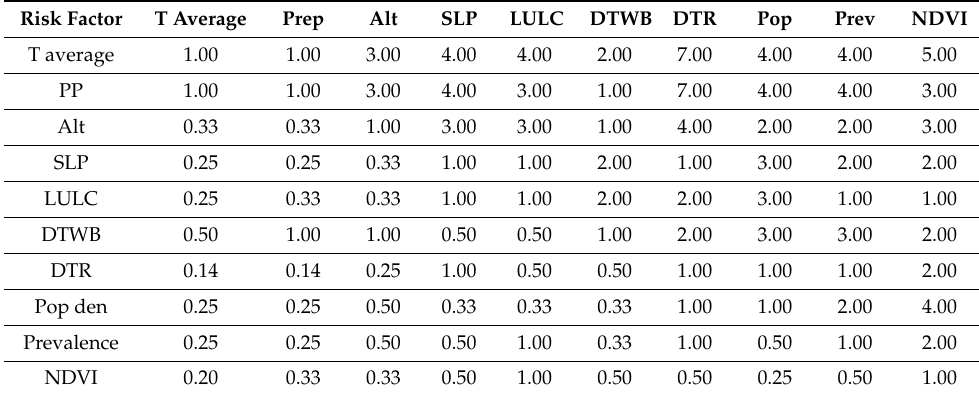
Table 3. 10 × 10 Comparison matrix of Risk Factors used in the